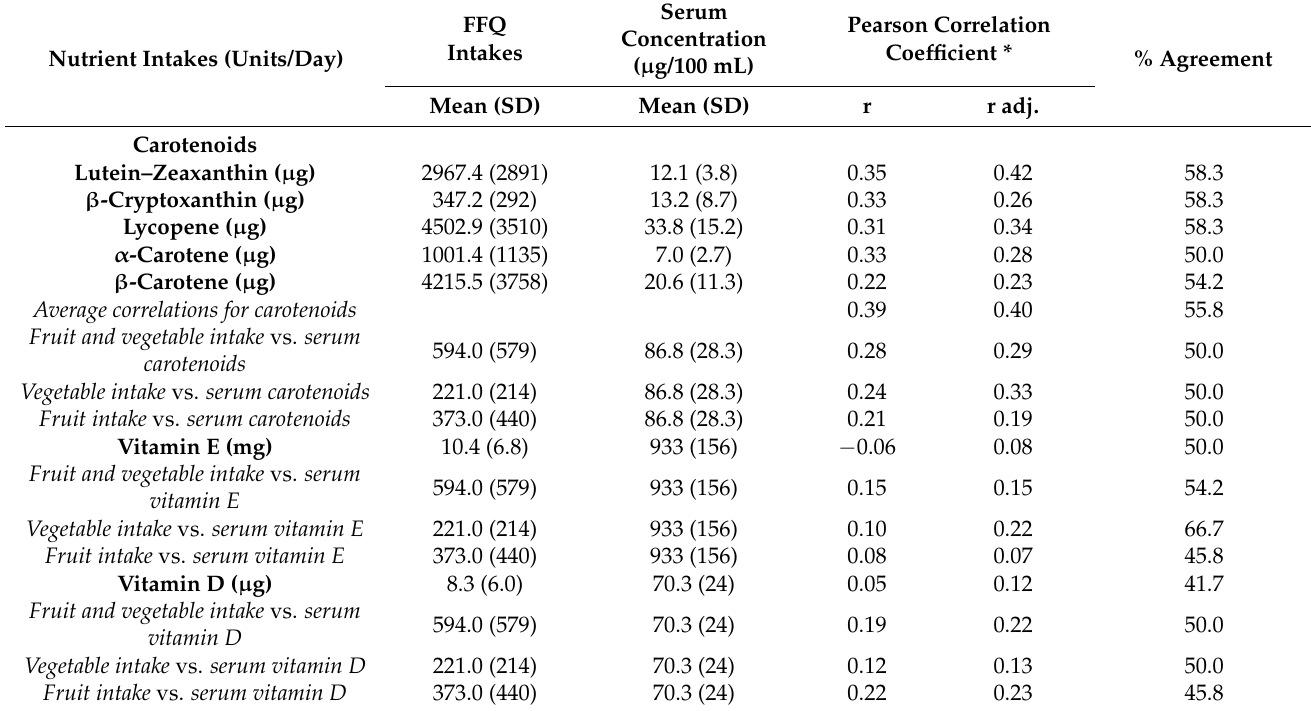
r: coefficient correlations for log-transformed nutrient intakes and serum carotenoids and vitamin levels. r adj: coefficient correlations for energy-adjusted nutrient intakes and cholesterol-adjusted serum carotenoids and vitamins. * Coefficients higher than 0.20 resulted in statistically significant results in this study ( p <